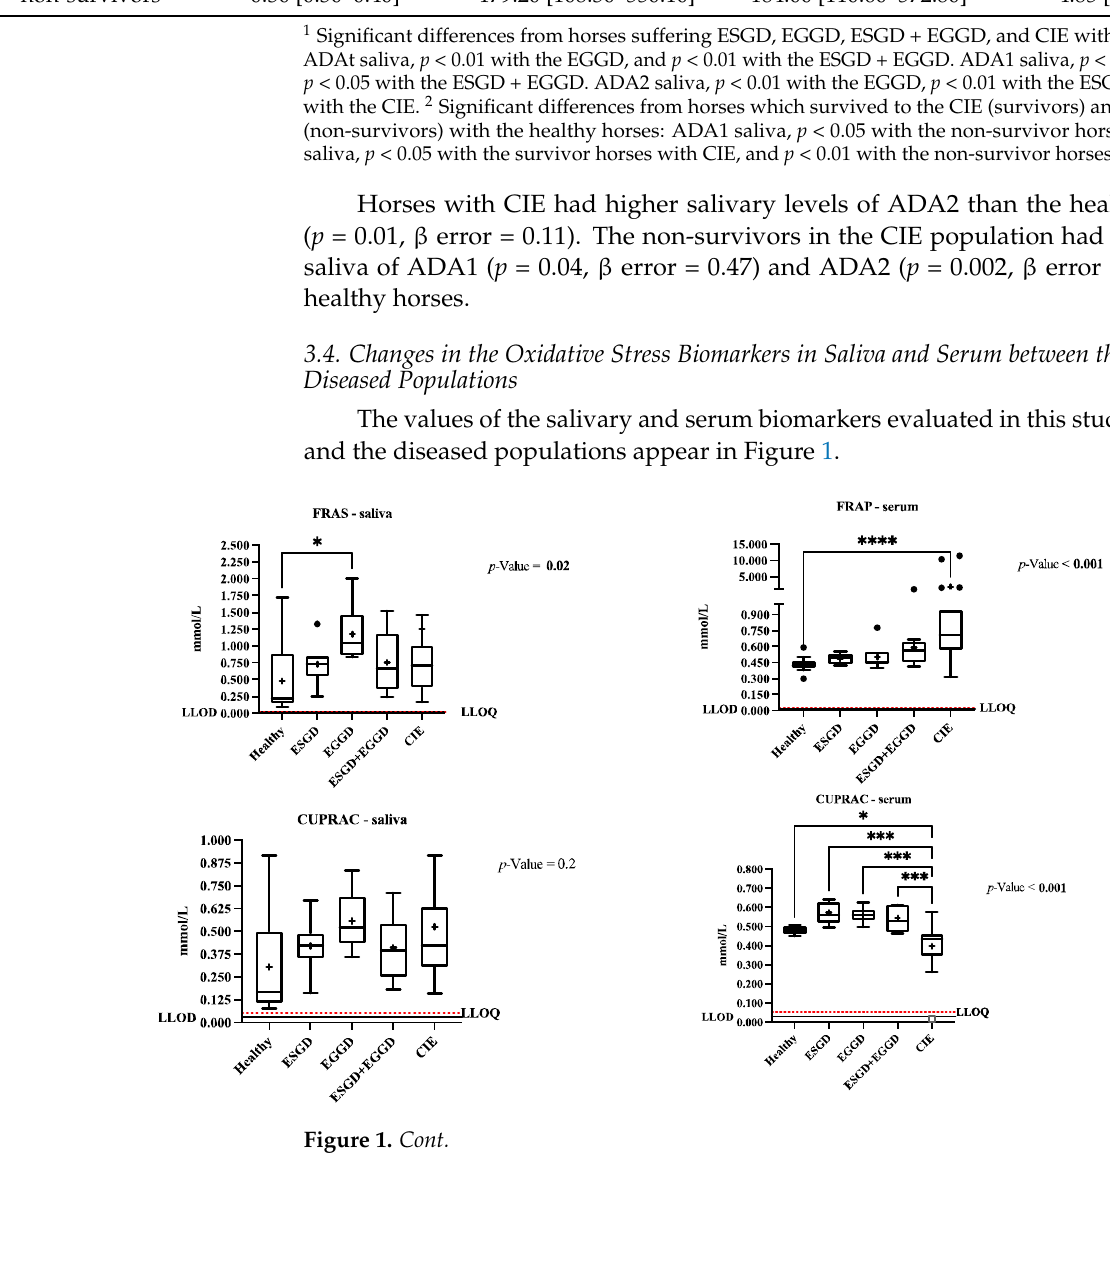
Figure 1. The ferric reducing ability of saliva/serum (FRAS/FRAP), cupric reducing antioxidant ca- pacity (CUPRAC), Trolox equivalent antioxidant capacity (TEAC), uric acid, and advanced oxida- tion protein products (AOPP) and ratio AOPP/albumin results in healthy horses ( n = 14), horses suffering Equine Squamous Gastric Disease (ESGD, n = 6), Equine Glandular Gastric Disease (EGGD, n = 8), ESGD + EGGD ( n = 9), and colic of intestinal aetiology (CIE, n = 22). The plot shows the median (line within box), mean (the cross inside the box), 25th–75th percentiles (box), 5th and